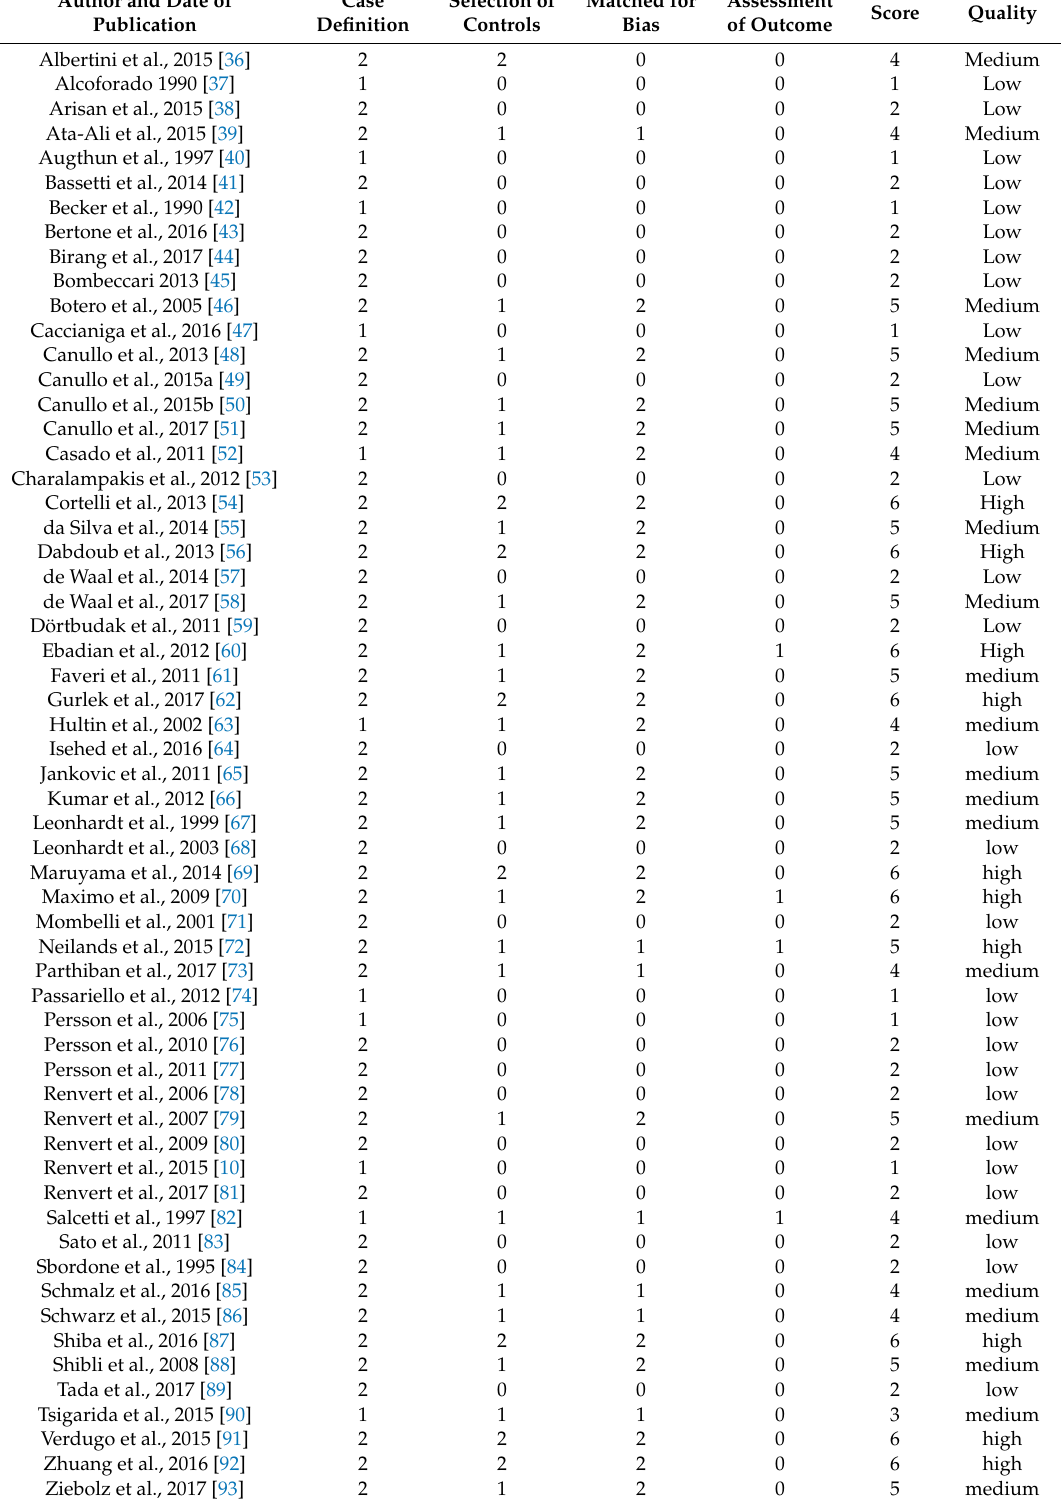
Table 1. Quality